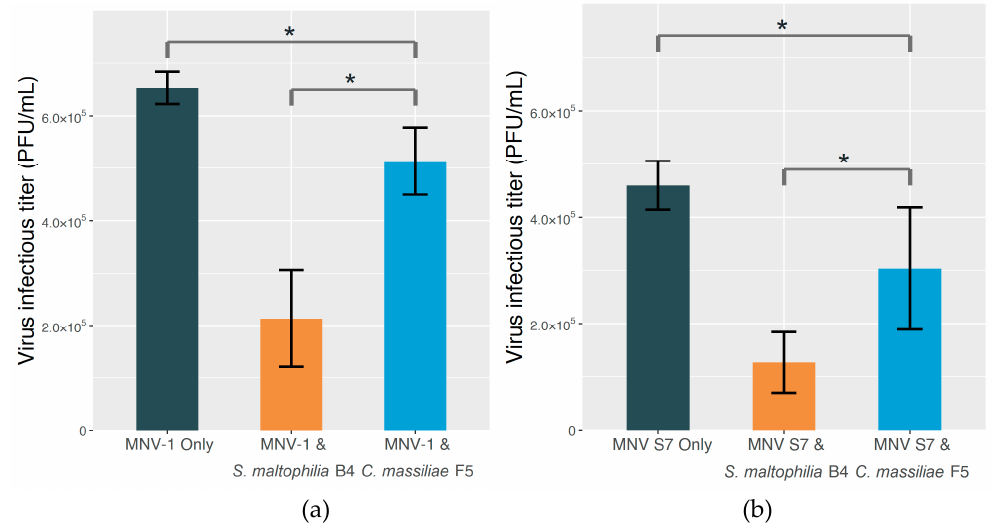
Figure 3. The plaque assay results for MNV with/without the addition of a bacterial strain. Prior to inoculation, centrifugation was performed as a measure to remove the virus particles bound to bacterial cells from the mixture. The extent of virus–bacterium binding is therefore reflected by the drop in plaque-forming unit (PFU) count. ( a ) Infectious titers of MNV-1 without either of the strains, MNV-1 with S. maltophilia B4, and MNV-1 with C. massiliae F5. ( b ) Infectious titers of MNV S7 without